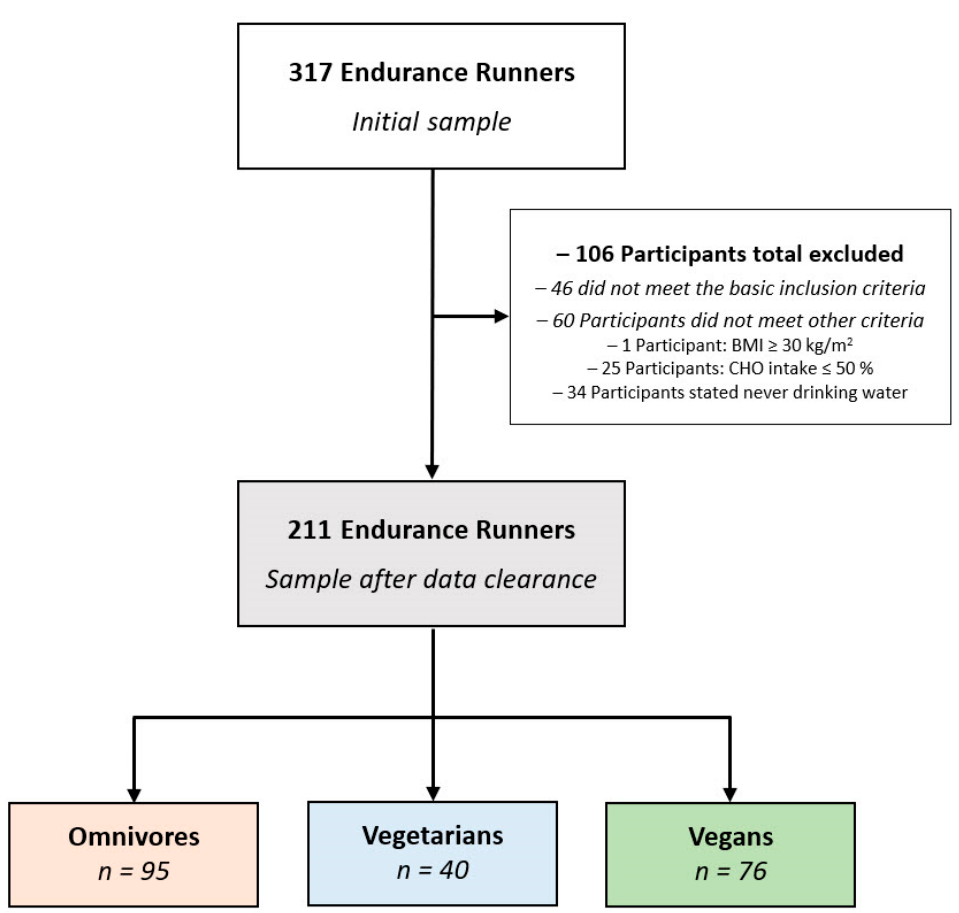
Figure 1. Participants’ enrollment and classifications by kind of diet.